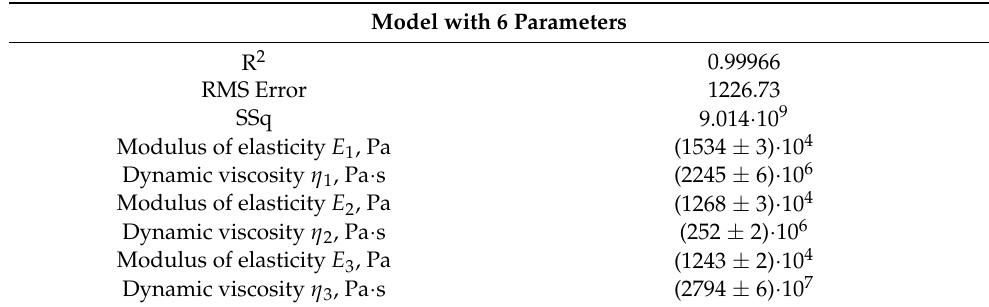
Table 3. Values of parameters in a generalized Maxwell model with six parameters for unaged asphalt binder containing 4.5%